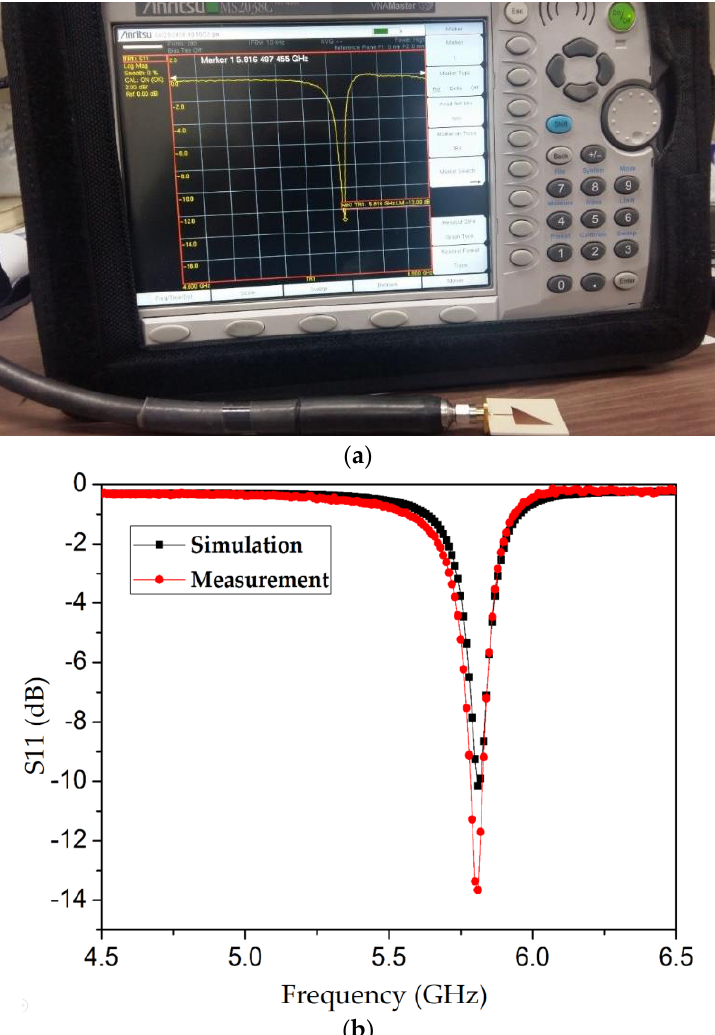
Figure 12. ( a ) Measurement setup: the proposed TM 02 -mode triangular QMSIW resonator (without loading of microfluidic channels) is measured using a vector network analyzer and resonates at 5.81 GHz. ( b ) Simulated and measured return-loss values obtained for the proposed resonator without the loading of microfluidic channels. The simulated unloaded Q ≈ 43 is calculated according to a 3-dB bandwidth at the resonance frequency. Table 2. Comparison between the simulation and measurement results after the loading of microfluidic channels. The resonant frequencies and return-loss measurements are provided, corresponding to empty channels and the four possible combinations of ethanol and DI water.